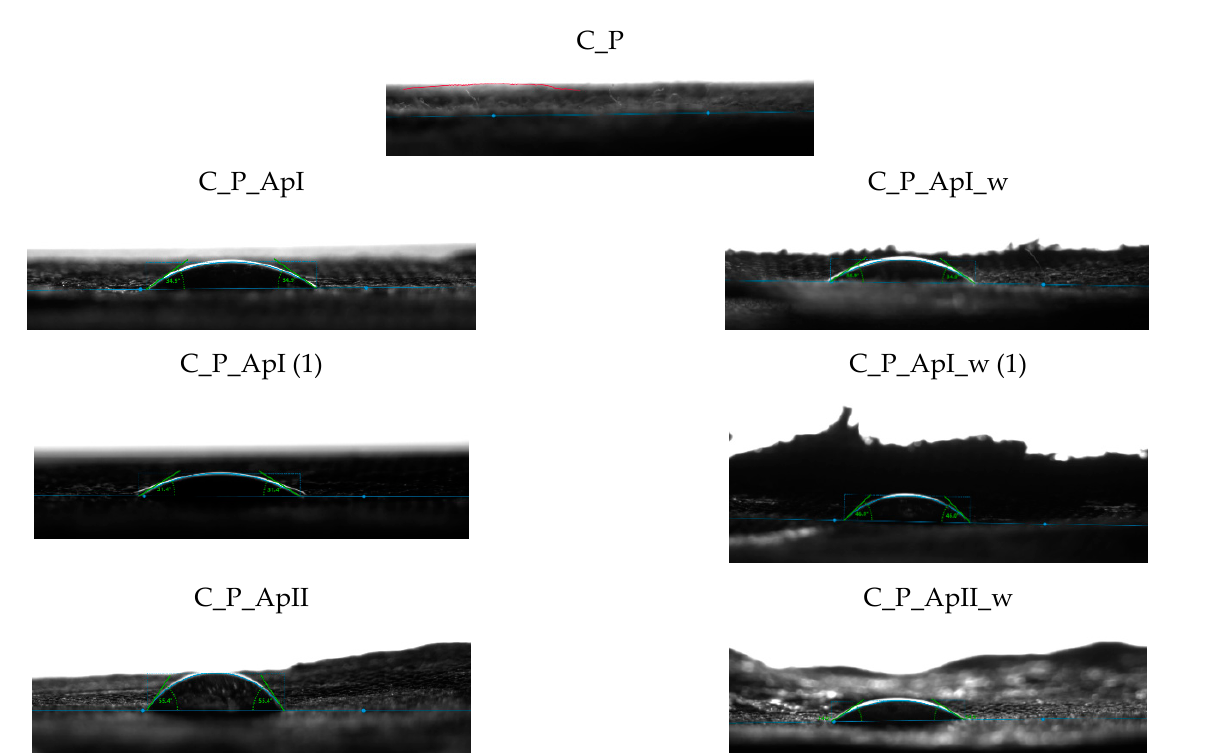
Figure 10. Photographs of a water drop on the plain weave fabric samples during contact angle measurement.